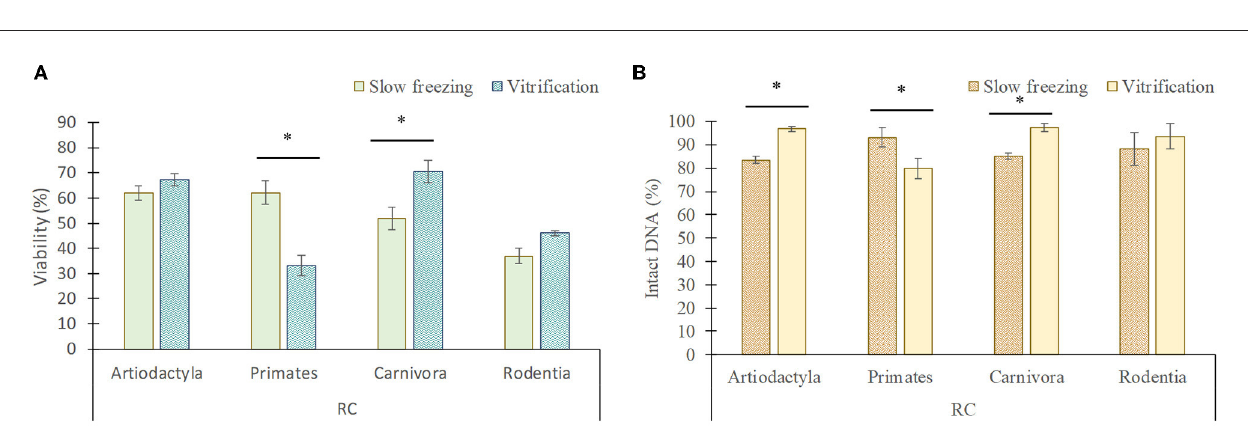
tended to decrease after slow freezing in comparison to vitrification (37 ± 3.2 vs. 45 ± 1.9%; P =